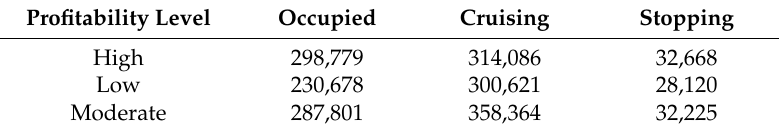
Table 6. Total number of the three types trips of the three profitability levels of the taxi